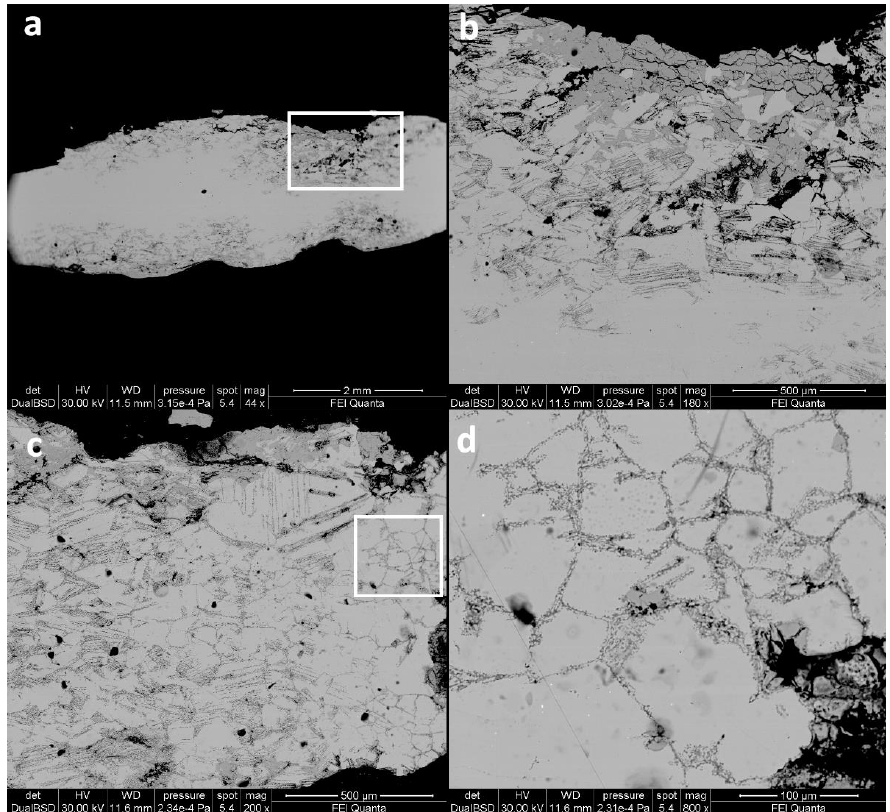
Figure 2. BSE images of cross section of sample F1. Here the corrosion patterns are well visible through the whole section. Moreover, in ( b , c ) the fine and parallel strain lines caused by plastic deformation are clearly visible, especially in proximity of the external corroded layer. Evidence of corrosion, with consequent dezincification following the grain boundaries, is visible ( c , d ). From ( a – d ) the magnification is increased: the highlighted area in ( a ) is expanded in ( b , c ), the highlighted area in ( c ) is expanded in ( d ).